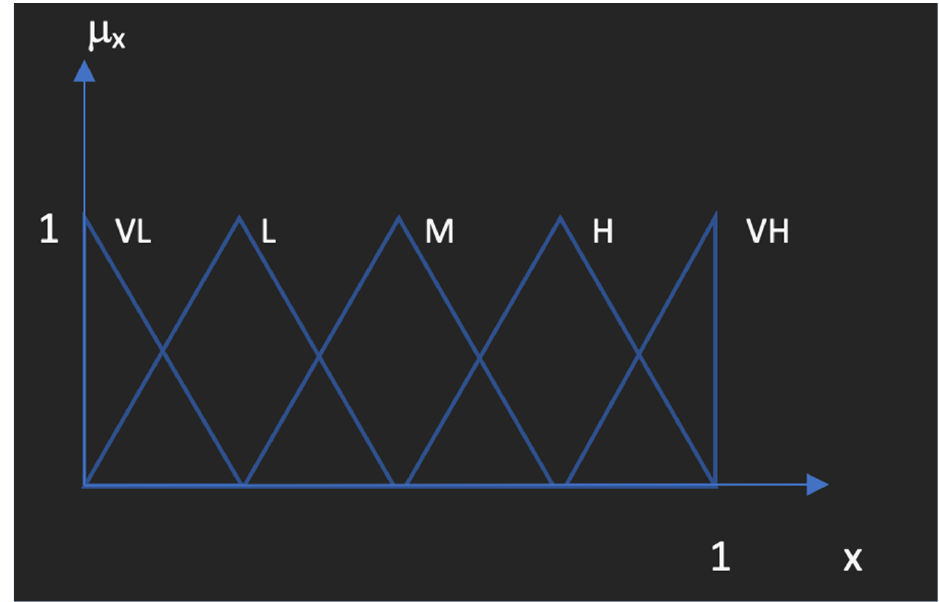
Figure 1. Linguistic fuzzy sets.